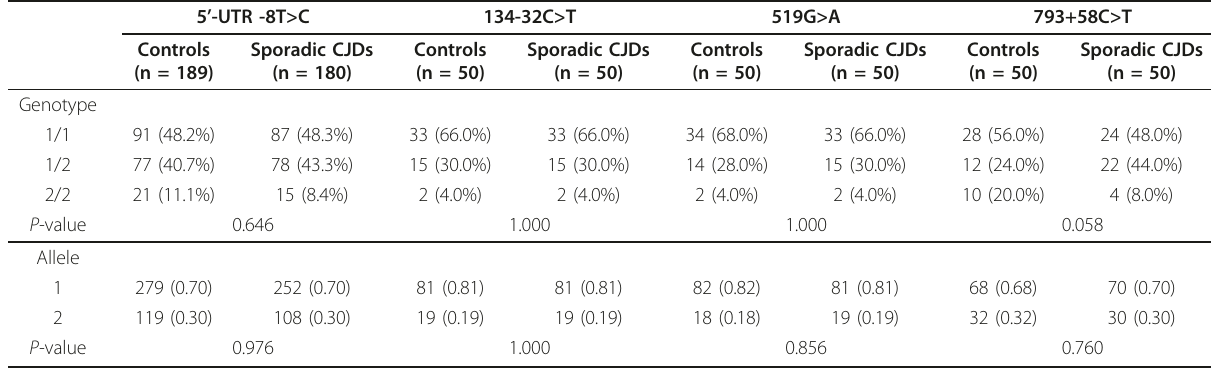
Table 4 Genotype and allele frequencies of RPSA polymorphisms in controls and sporadic CJD patients 5 ’ -UTR